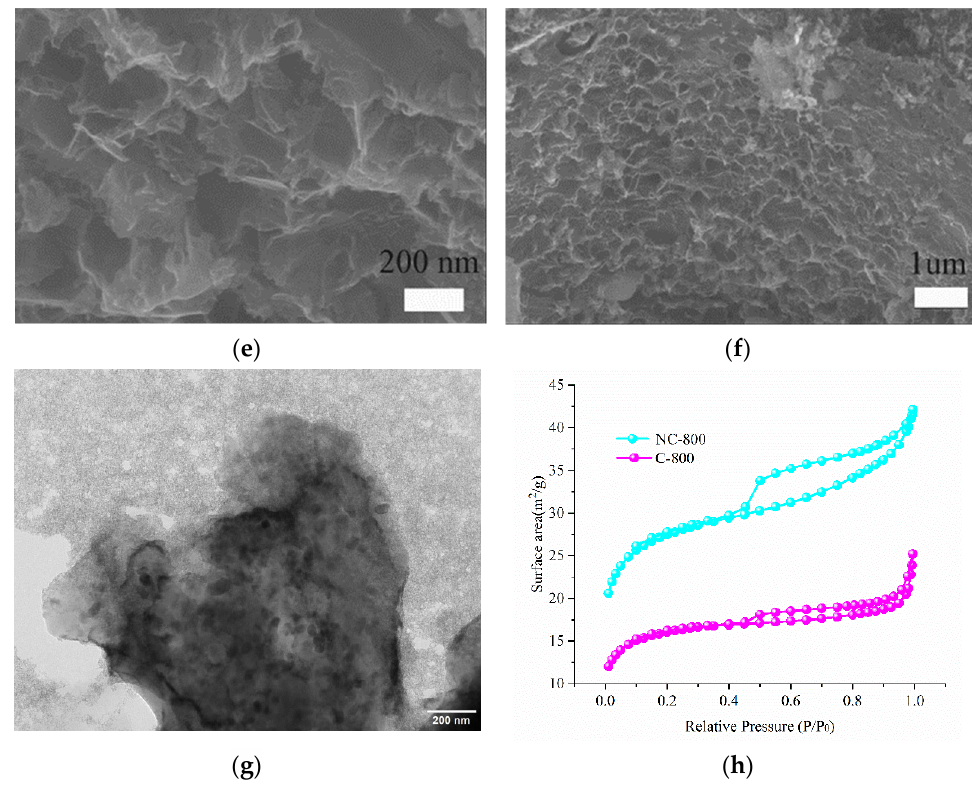
Figure 1. ( a ) XPS spectra; ( b ) Raman spectra of NC-800 and C-800; ( c ) C1s XPS spectra ( d ) N1s XPS spectra ( e ) SEM images of NC-800(200 nm); ( f ) SEM images of NC-800 (1 µm) ( g ) TEM images of NC-800 ( h ) BET of NC-800 and C-800. Table 1. Carbon, Nitrogen and Oxygen content of NC-800 and C-800.